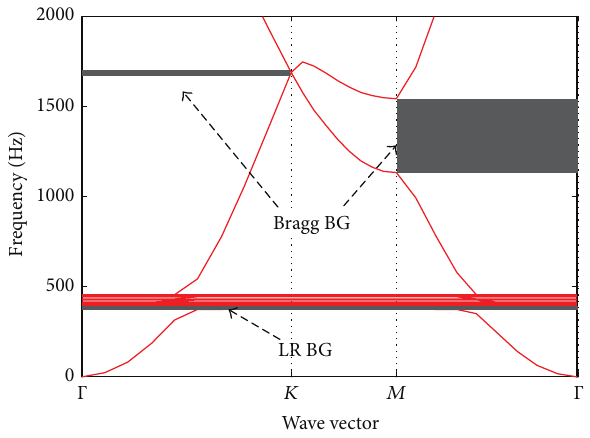
Figure 9: Band structure of the two-dimensional PPC-C of trian- gular lattice.